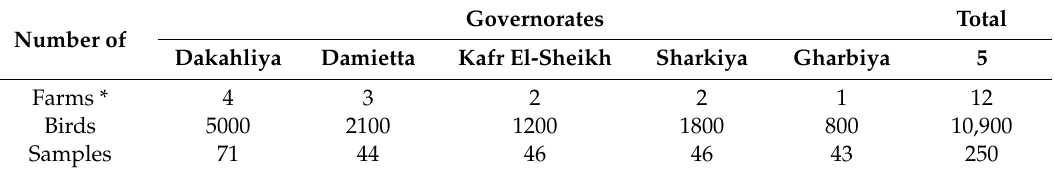
Table 1. Investigated turkey farms in northern Egypt, the number of birds, and the number of collected